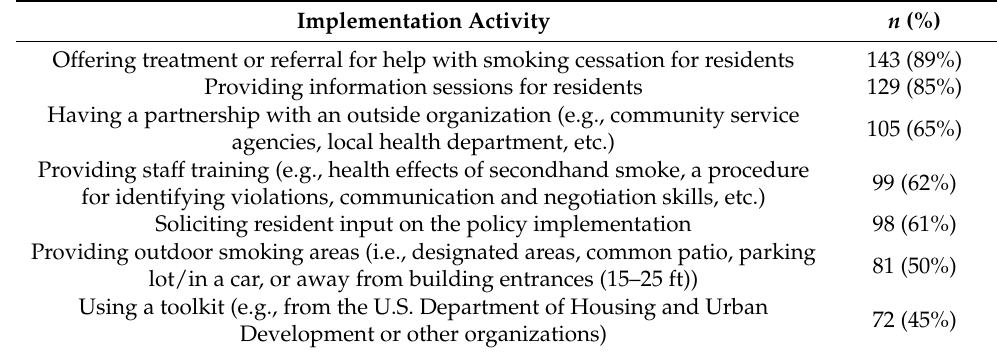
Table 1. Implementation activities in public housing authorities that adopted smoke-free policies prior to January 2018 ( n =